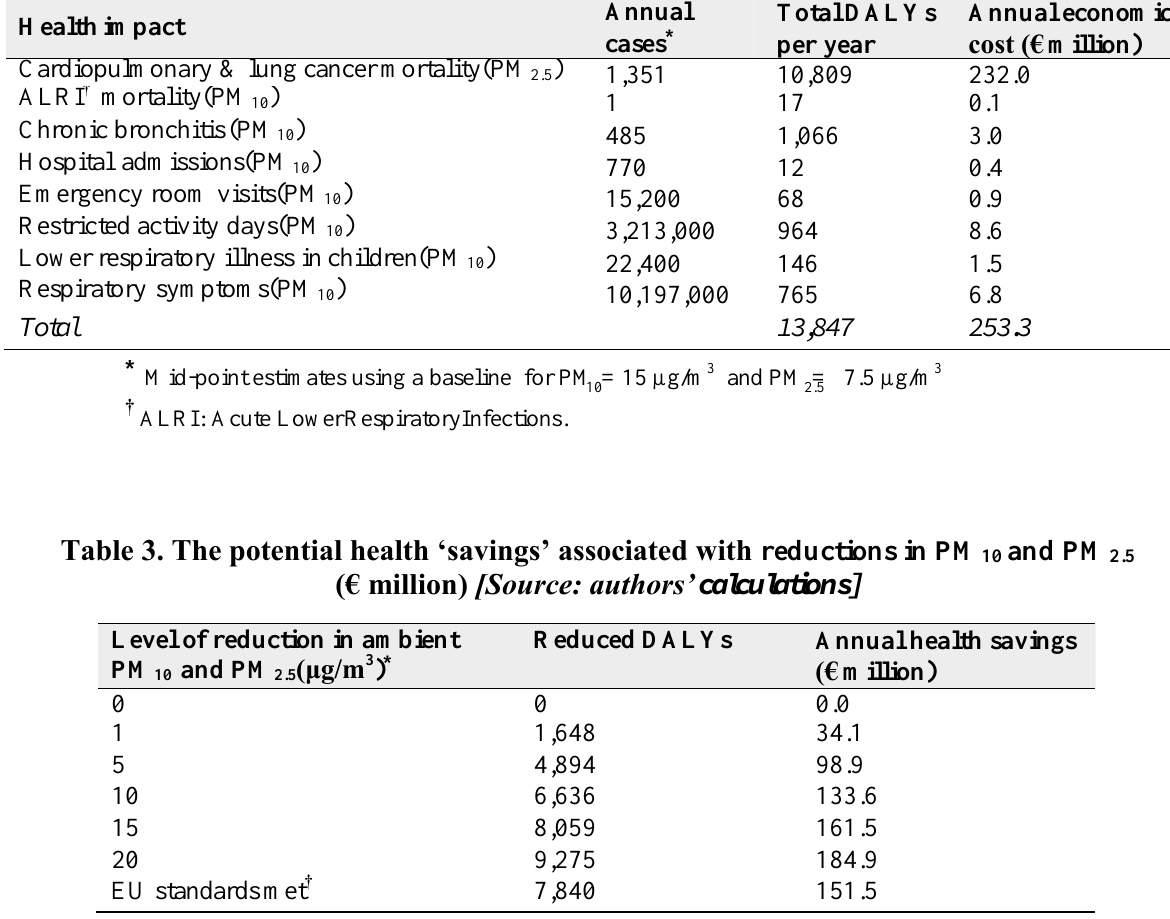
Table 2. Number of annual cases, DALYs per year and economic cost in millionEuros, 2011 (Source: authors’ calculations)